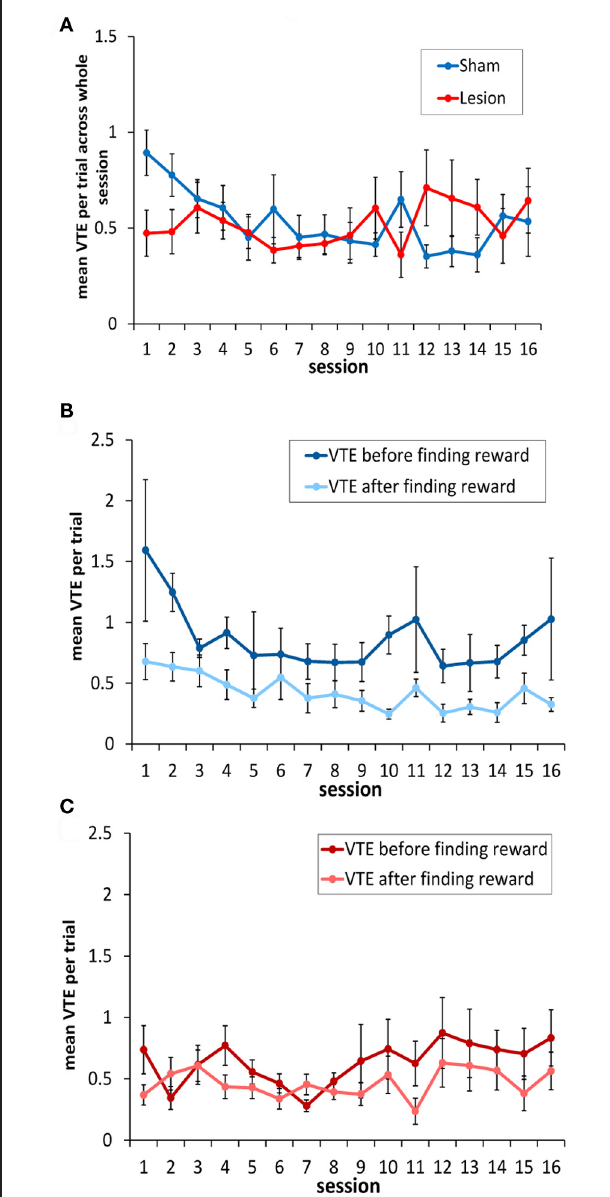
FIGURE 5 | Vicarious trial-and-errors in hippocampus- and sham-lesioned animal. (A) With the exception of session 1, animals with hippocampus damage showed a similar number of VTEs to sham lesioned animals. (B) Sham-lesioned animals made significantly more VTEs before finding the rewarded goal box in each block, compared to after this location had been identified. (C) In contrast, animals with hippocampus damage showed a similar number of VTEs both before the rewarded goal box had been found in each block, and after it had been found.